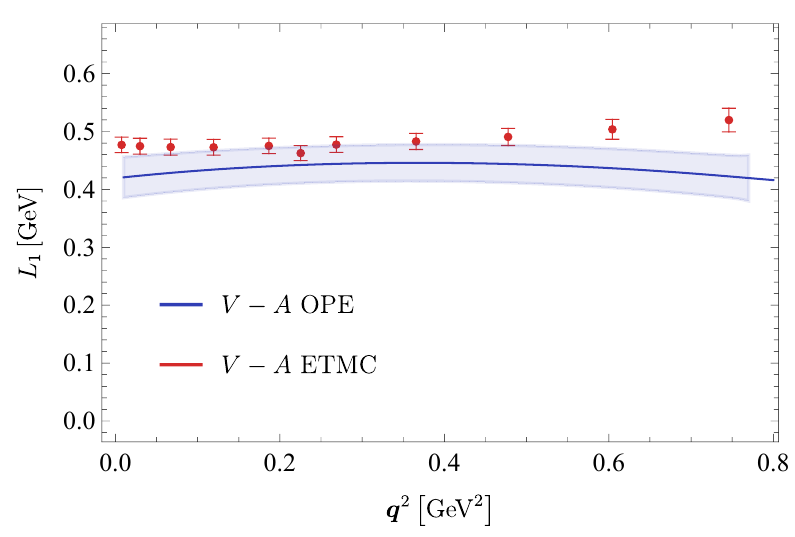
Figure 15 . Differential lepton energy mean value, L 1 ( q 2 ) , in the SM. The comparison of OPE with ETMC data is shown.